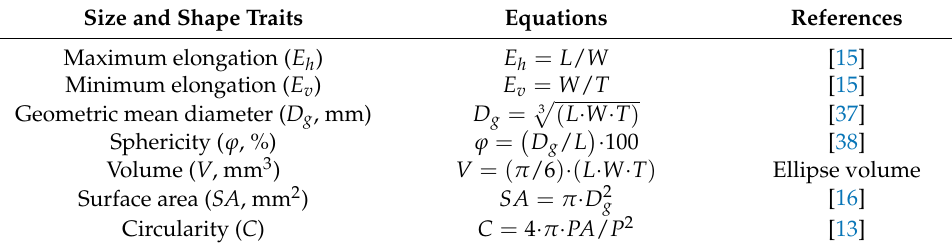
Table 1. Equations used for size and shape traits of the grape